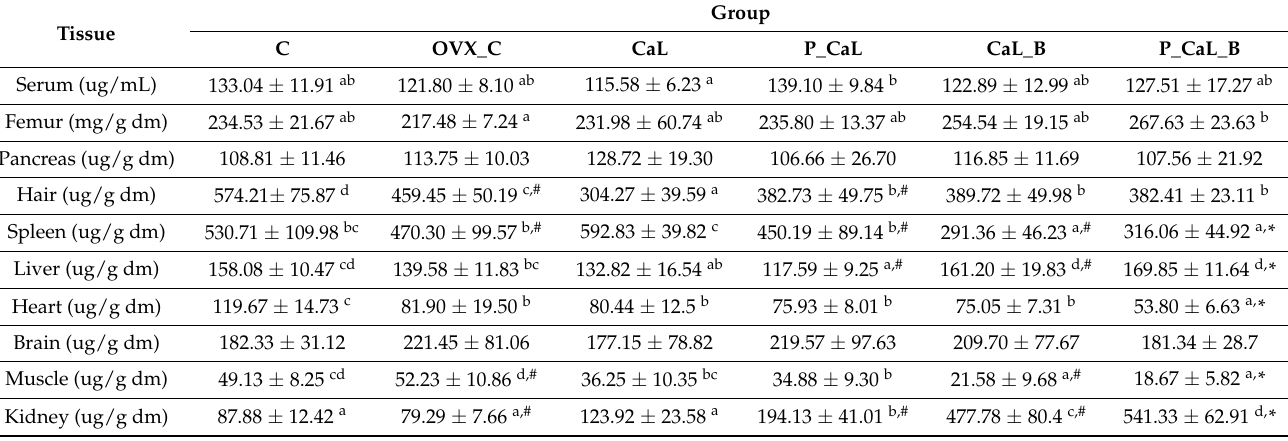
Table 4. Calcium content in the serum and tissues (mean and standard deviation).